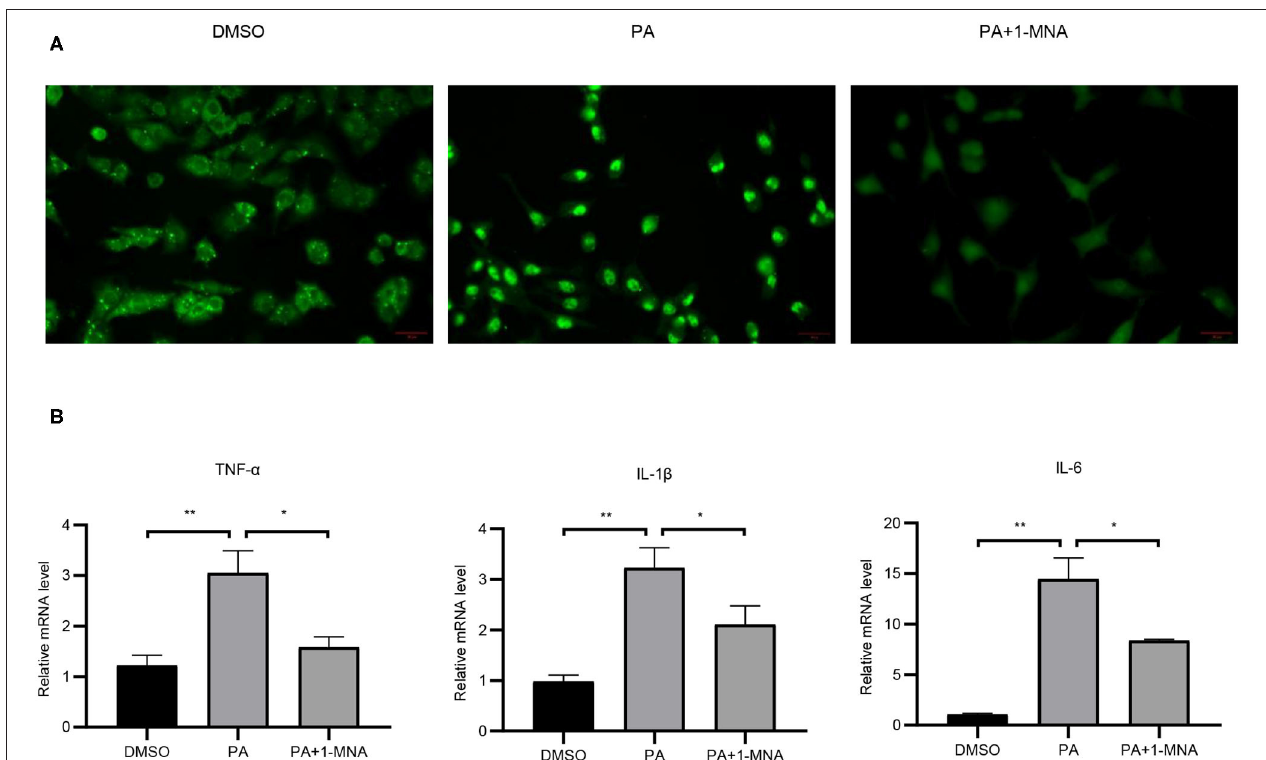
FIGURE 3 | Effects of 1-MNA on PA-induced inflammation in H9C2 cells. (A) Immunofluorescence assay for NF- κ B p65 nuclear translocation for NF- κ B activity. (B) The mRNA expression of inflammatory cytokines. β -actin was taken as an internal control gene. Expression is expressed as the mean ± SEM. Differences in expression were analyzed by the unpaired Student ′ s t -test and one-way ANOVA ( n = 3, NS = no significance, * P < 0.05, ** P < 0.01).